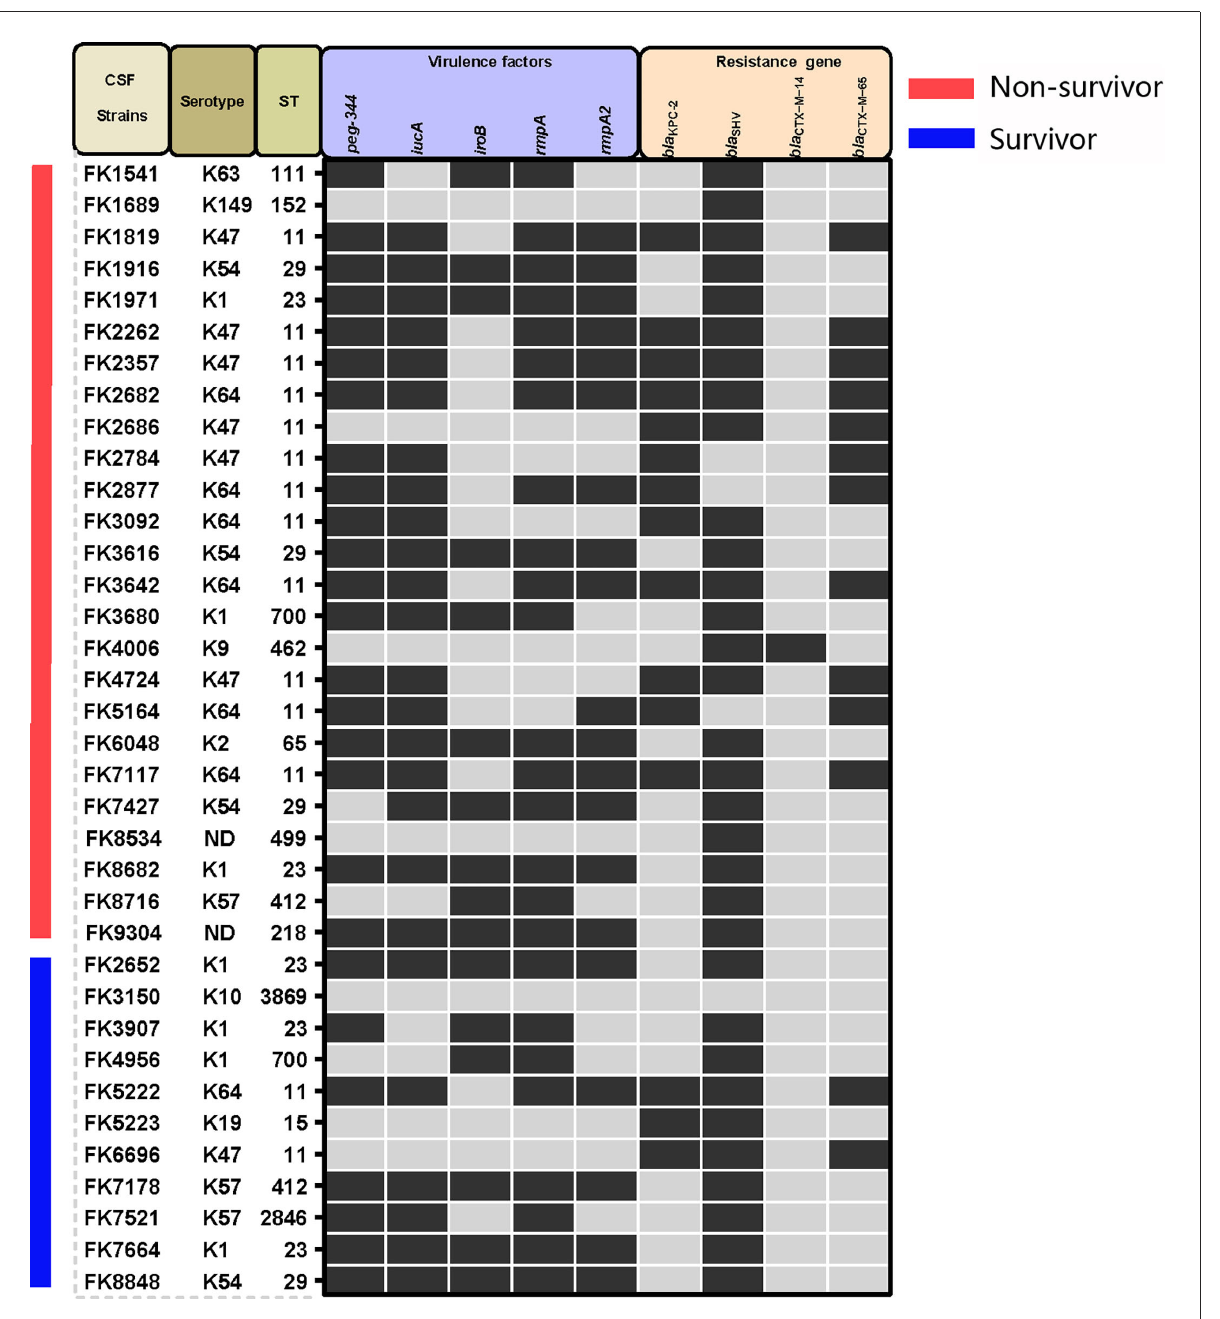
HvKP and cKP groups. However, as compared to the